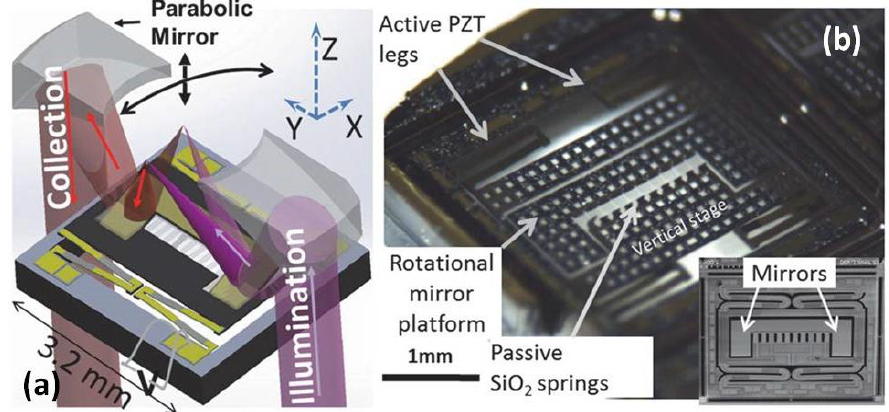
Figure 10. MEMS-based dual-axis confocal (DAC) microendoscope. ( a ) Schematic drawing of the MEMS vertical-rotational stage scanning for cross-sectional imaging with the DAC microendoscope. ( b ) Photograph of the vertical-rotational MEMS scanning stage based on an active outer vertical displacement and a passive inner resonant scanning. Inset: Variant with solid dog-bone mirror surface for the DAC microscope. Reproduced with permission from [55]; published by IEEE, 2014.